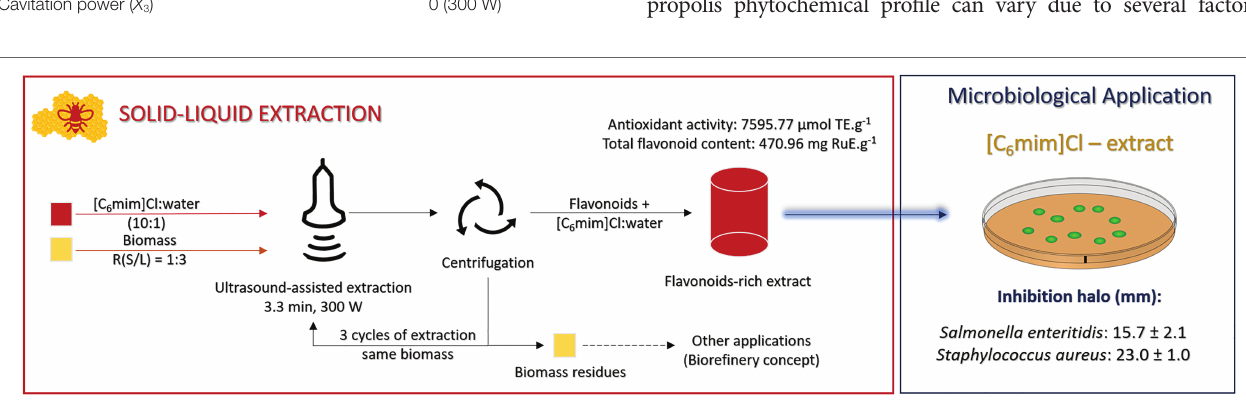
FIGURE 2 | Optimized process designed for high recovery of phytochemicals from red